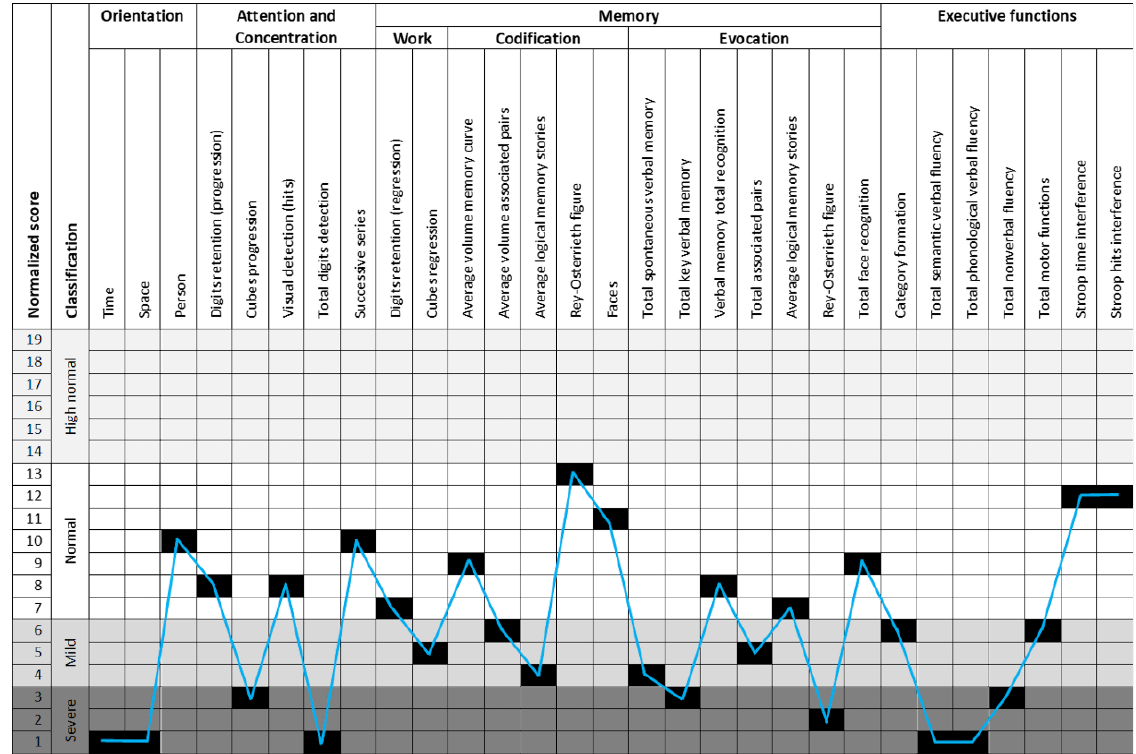
Figure 3. Neuropsi test results. The 26 tasks included assessing each neuropsychological function